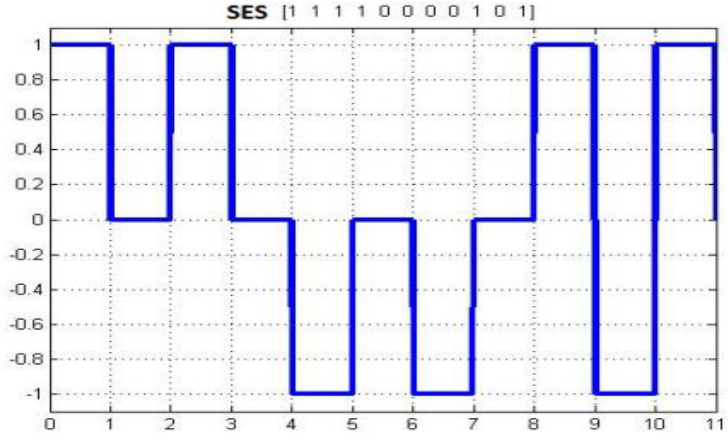
Figure 4. Shadow Encoding Scheme (SES) waveform.